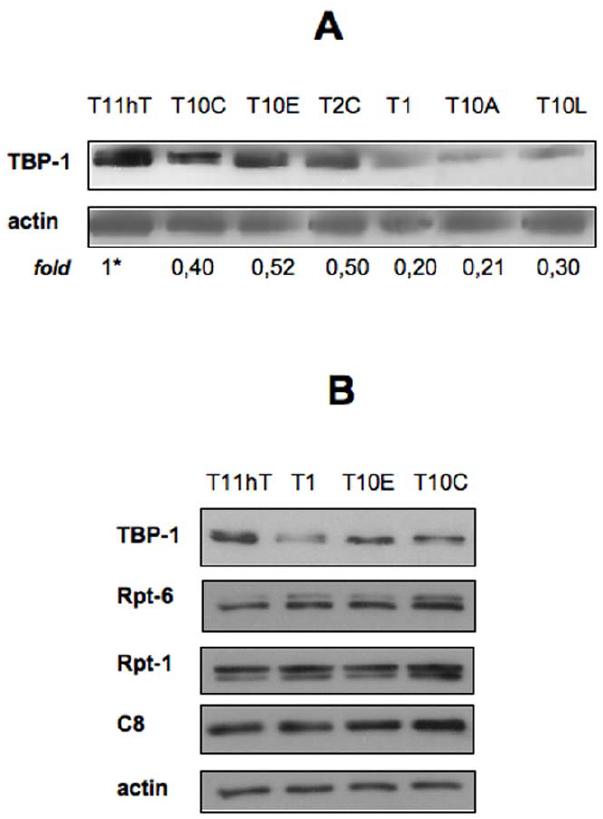
Figure 1. Characterization of TBP-1 silenced clones. A, B: Cells stably transfected with TBP1 sh -RNA plasmid or control cells (wt T11hT, Human Primary Fibroblasts Immortalized by hTERT) were cultured in DMEM + 10%FBS for 24 hrs. Levels of TBP-1 expression was evaluated by Western Blot with anti-TBP-1 on whole protein lysates. B : As control, protein levels of other proteasome components (two 19S-ATPases, Rpt- 1 and Rpt-6, and a 20S component, C8) was evaluated in the clones T1, T10C and T10E. Bands intensity was evaluated by ImageQuant analysis on at least two different expositions to assure the linearity of each acquisition, each normalised for the respective actin values. Asterisk, fold value is expressed relative to the reference point (i.e. TBP-1 levels in T11hT cells), arbitrarily set to 1. Representative of at least four independent experiments.